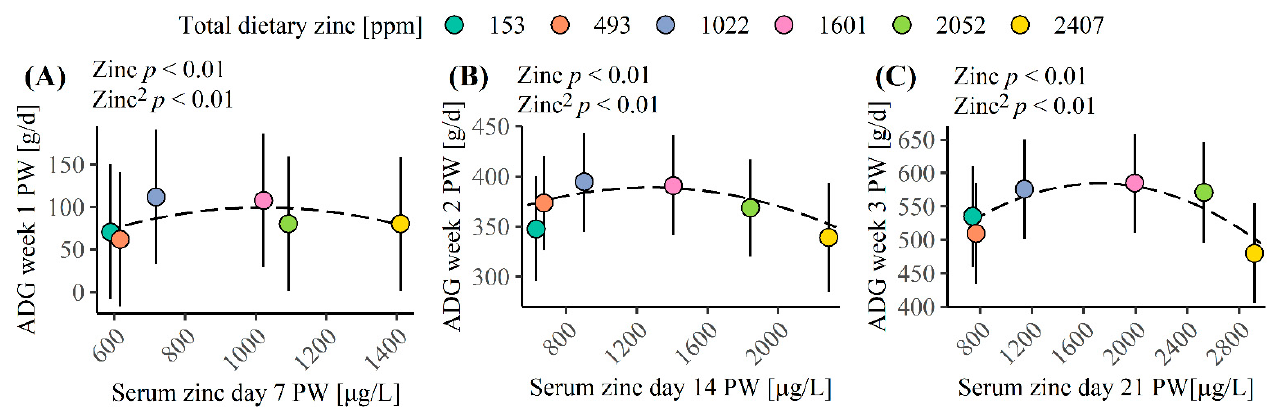
Figure 3. Average daily gain (ADG) as a function of serum zinc concentration. ( A ) The ADG for the first week post-weaning (PW) and the mean serum zinc concentrations at day 7 PW. ( B ) The ADG for the second week PW and the mean serum zinc concentrations at day 14 PW. ( C ) The ADG for the third week PW and the mean serum zinc concentrations at day 21 PW (30 pigs/diet). The black dashed line illustrates the effect of serum zinc concentration on ADG.